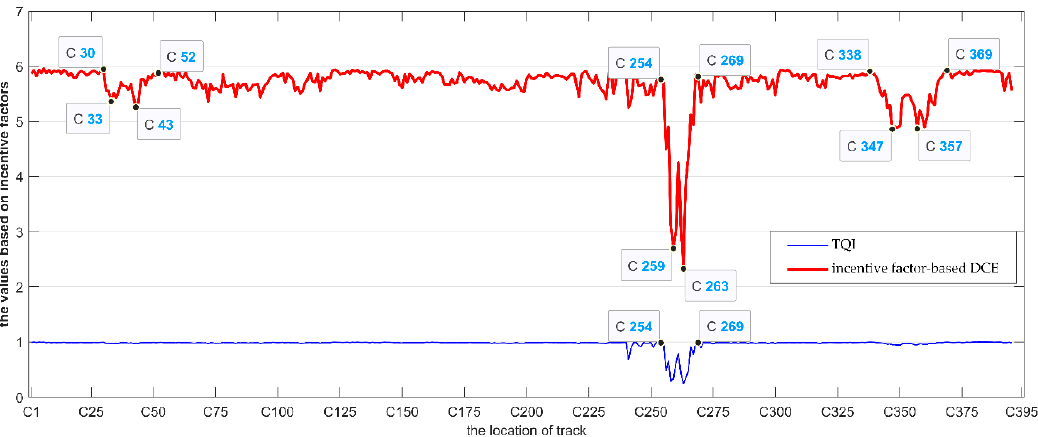
Figure 2. Comparison of the TQI and the incentive factor-based DCE.